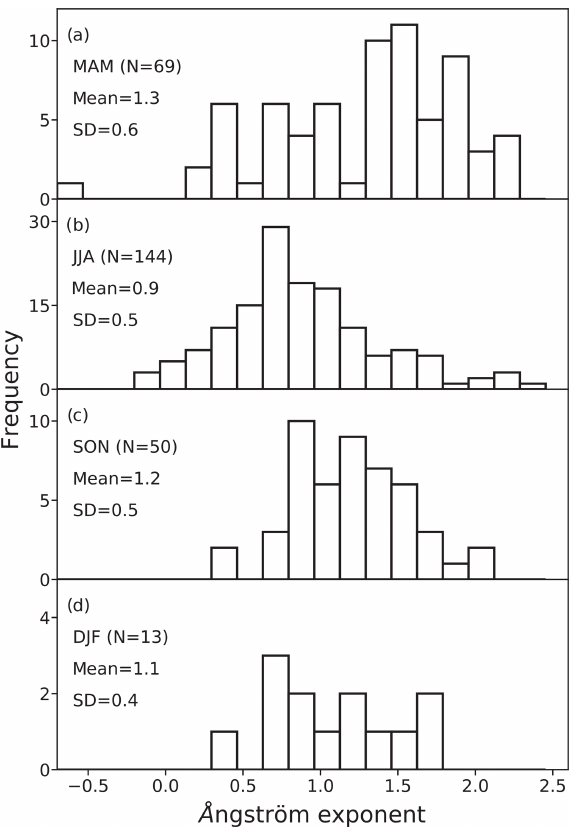
Figure 4. Same as Fig. 2, except for the extinction-related Ångström exponent ˙ a α, 355 / 532 .